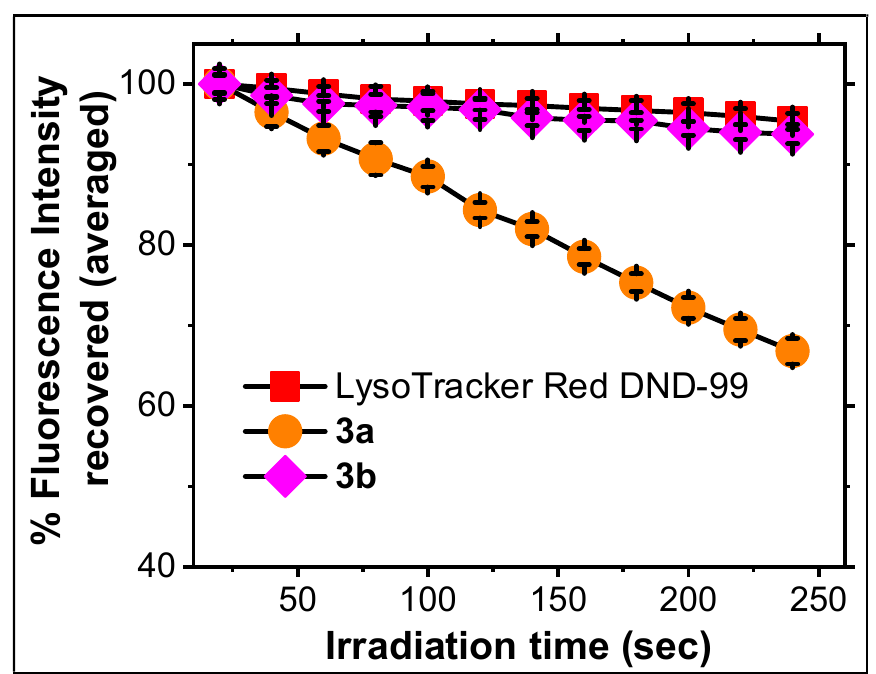
Figure 5. The plot of recovered fluorescence intensity versus irradiation time calculated for probes 3a , 3b and LysoTracker TM Red DND-99 (100 nM) in MO3.13 cells upon continuous irradiation (Laser power percentage 3.0; Digital zoom = 1; Pinhole = 1AU; Master Gain = 150; Digital offset = 0).